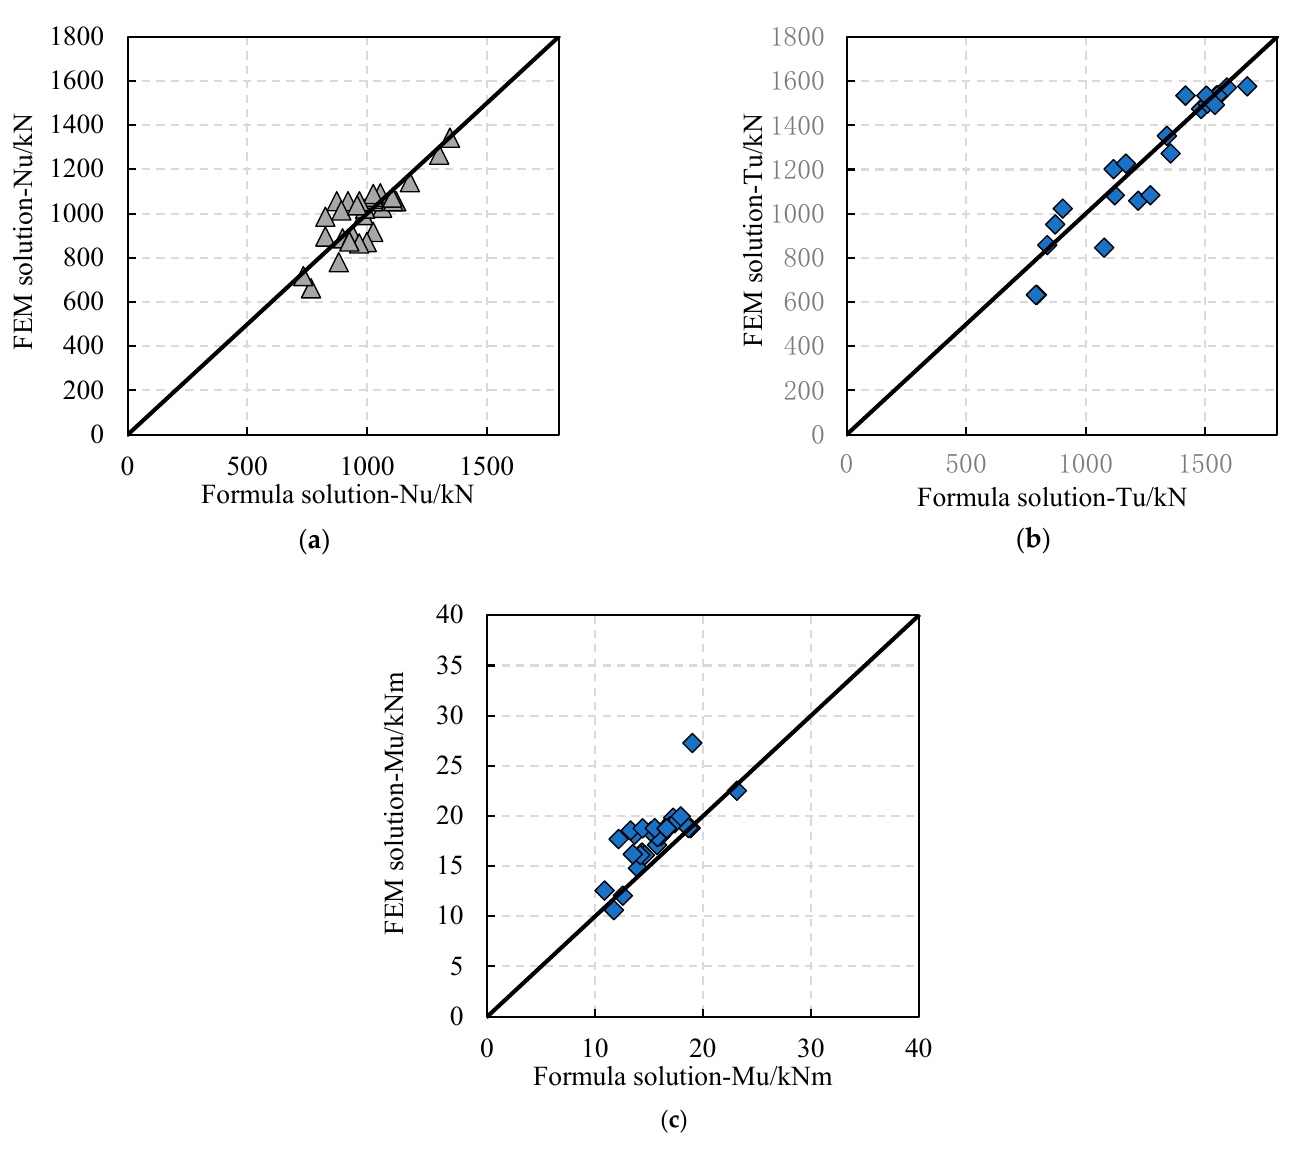
Figure 15. Comparison between formula solutions and test results: ( a ) ultimate compressive load-bearing capacity; ( b ) ultimate tension load-bearing capacity; ( c ) ultimate bending capacity. Table 11. Reliability verification of the load-bearing capacity